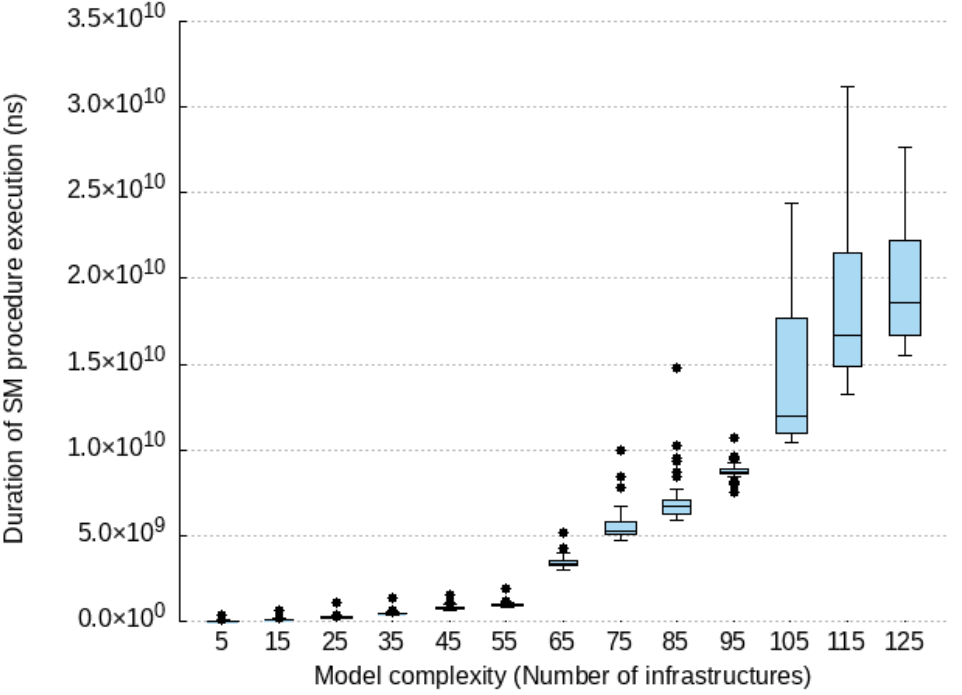
Figure 9. Measurements of SM procedure execution duration compared to constraint model